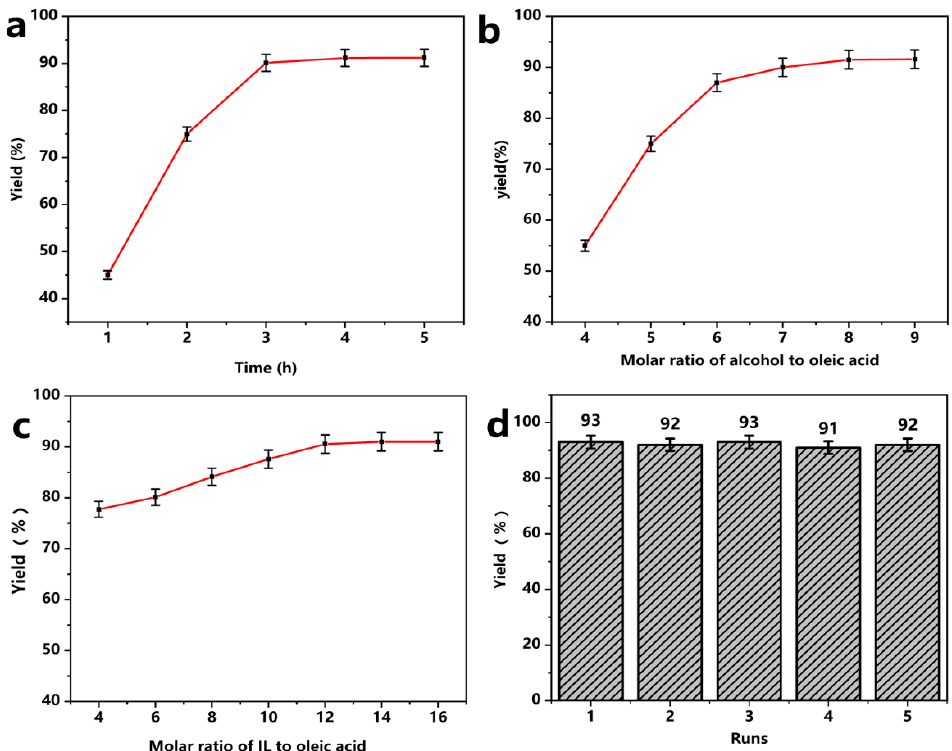
Figure 7. Impacts of reaction parameters on biodiesel production catalyzed by [HCP pitch –Im–Pros][Tos]. ( a ) 2.82 g oleic acid; 8% catalyst amount; n(methanol):n (oleic acid) = 7:1; 3 h; ( b ) 8% catalyst